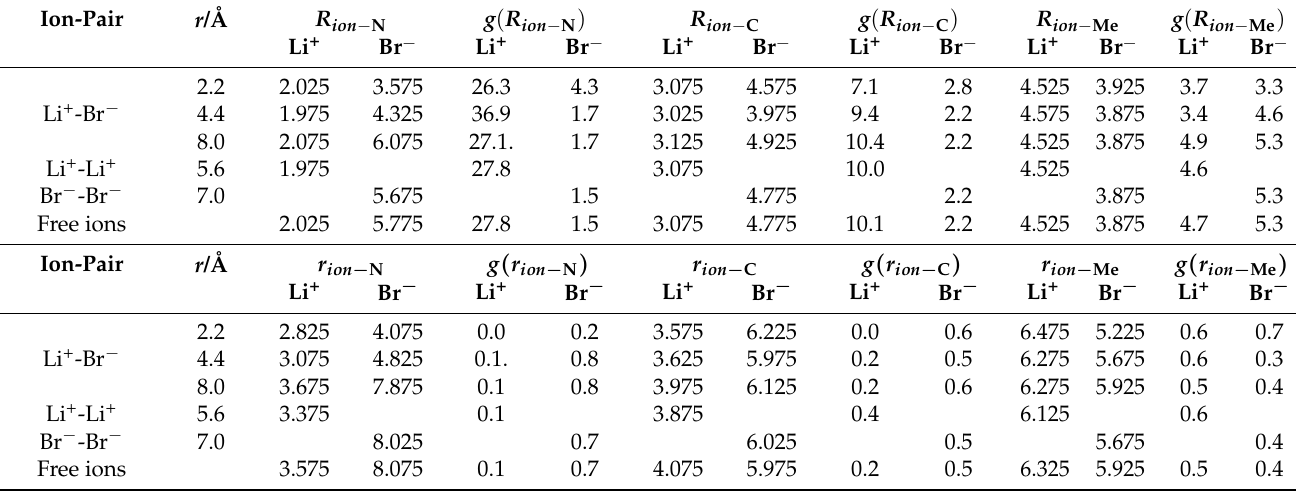
Table 7. Maximum ( R ion − atom ) and minimum ( r ion − atom ) radial distribution functions for the various cases. Ion-Pair